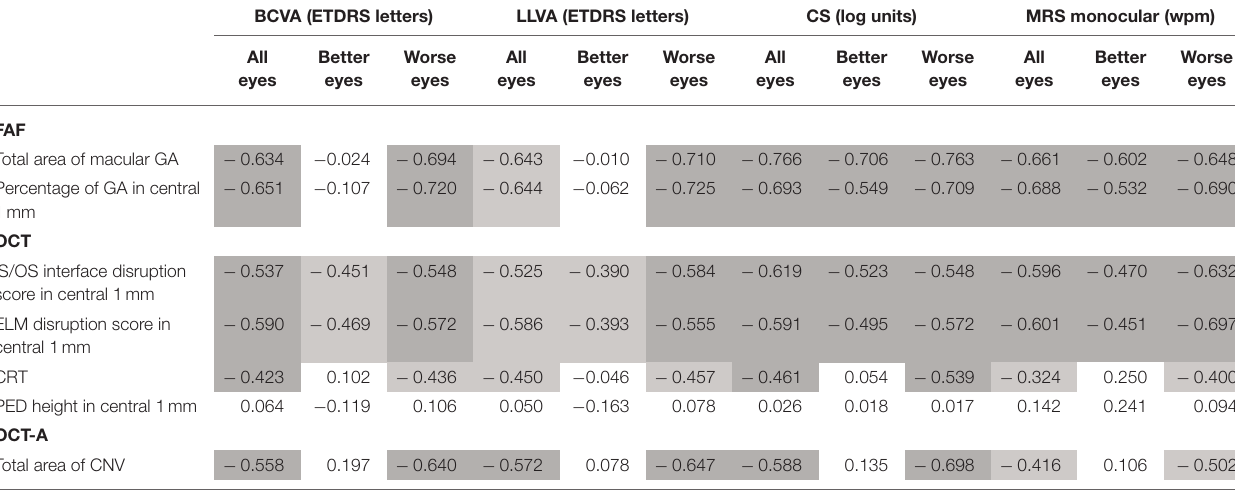
TABLE 3 | Correlations between visual acuity measures, OCT, FAF and OCT-A parameters.